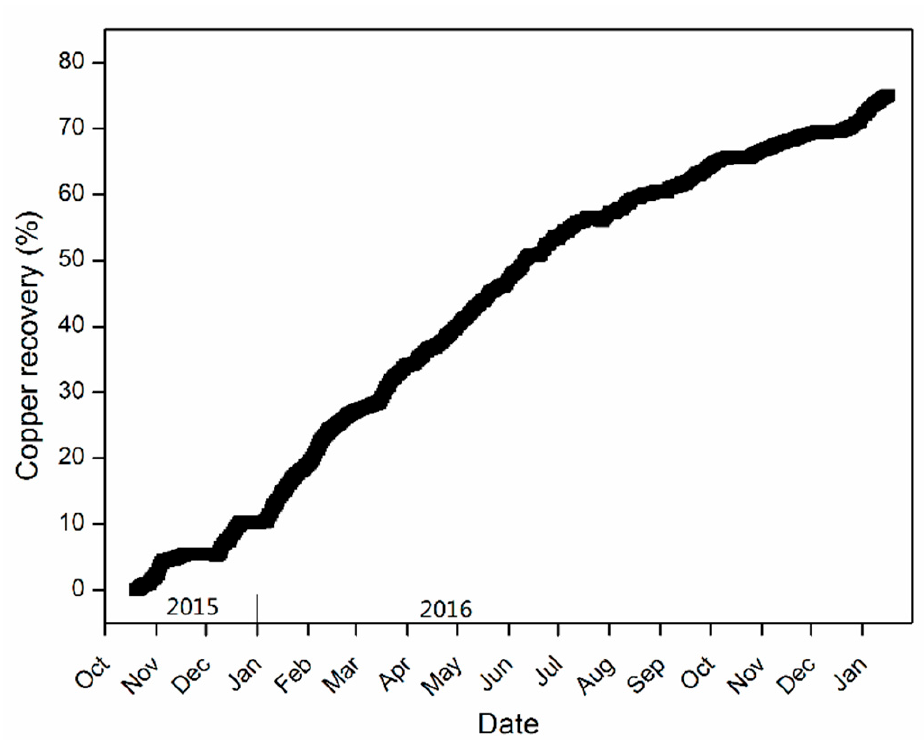
Figure 10. Copper recovery of the P3C6 cell during heap bioleaching.